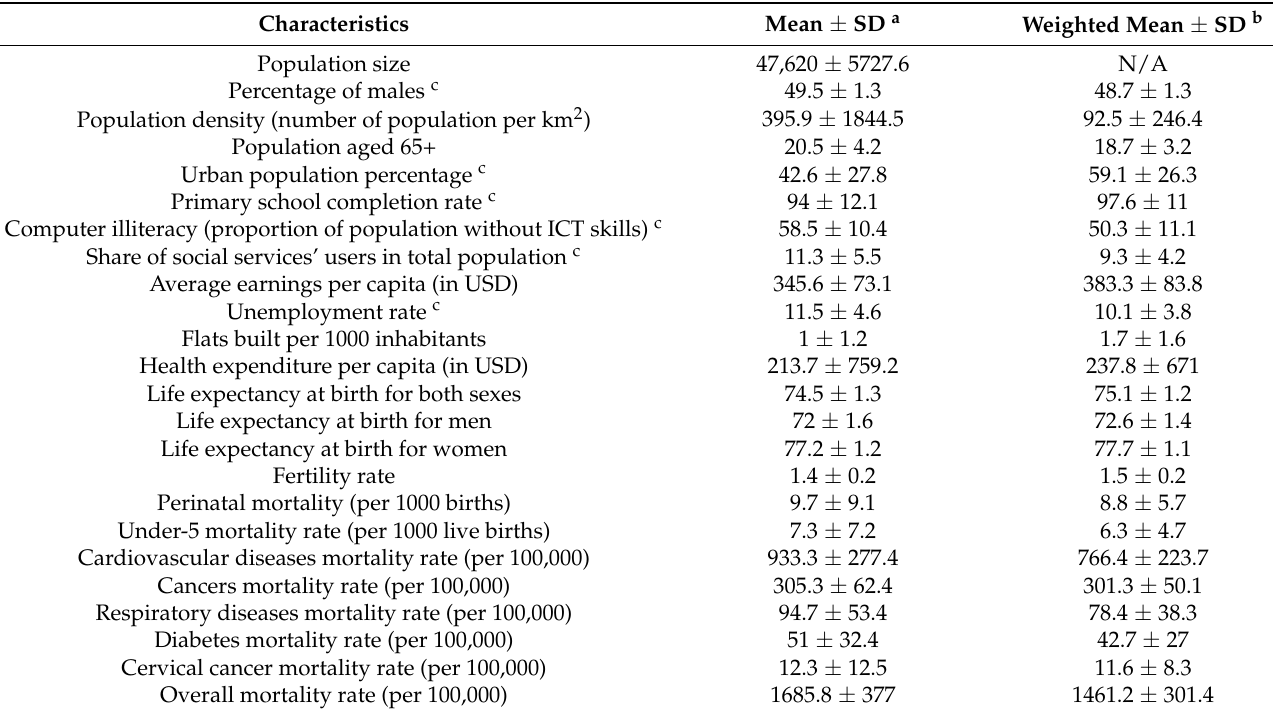
Table 1. General profile of the population and health status in 149 Republic of Serbian municipalities.